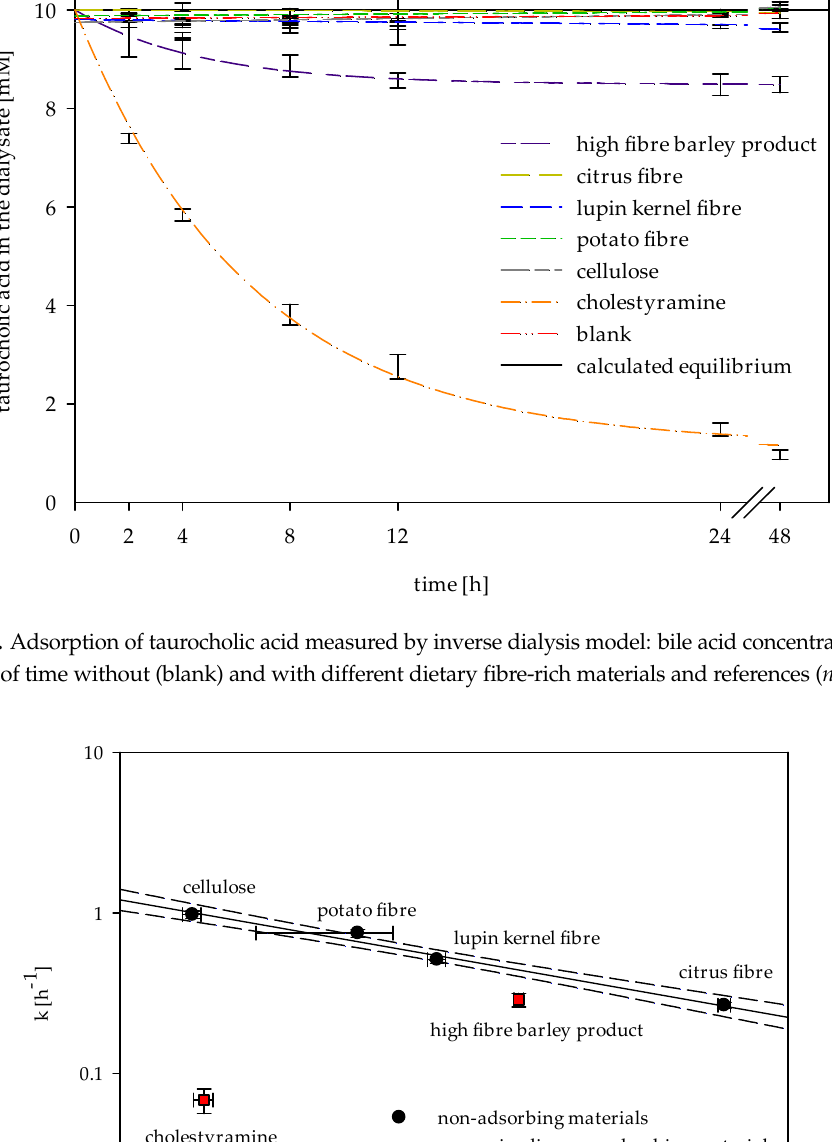
Figure 4. Correlation of apparent permeability rate (k) and the viscosity (shear rate 15 s −1 ) of in vitro digested chymes.